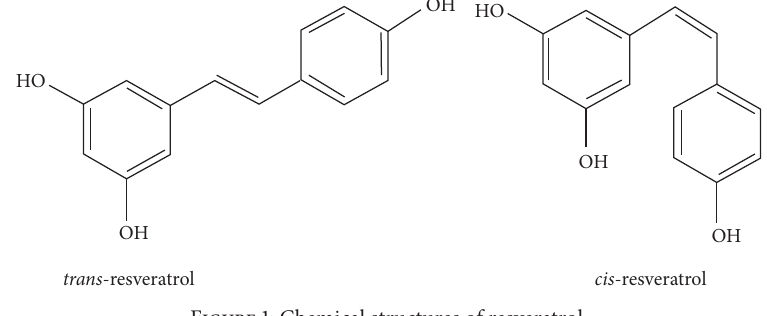
Figure 1: Chemical structures of resveratrol.